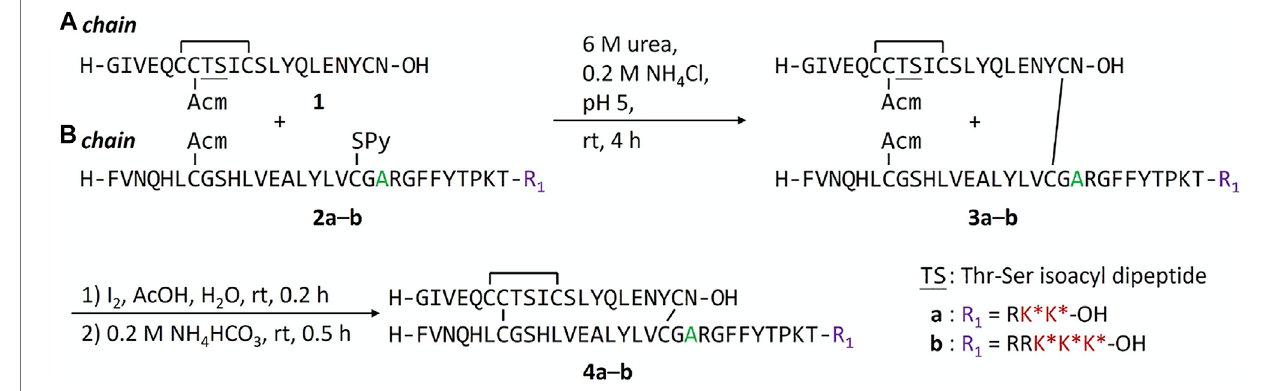
Frontiers in Chemistry |